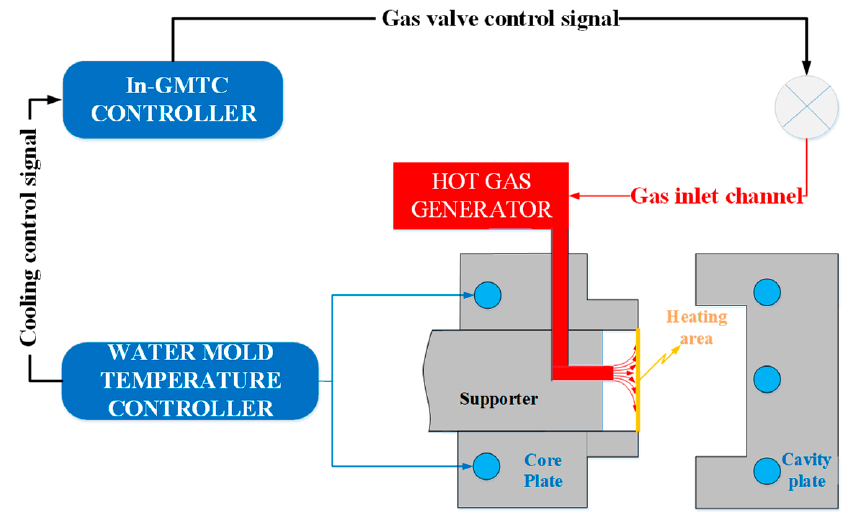
Figure 1. The In-GMTC system.